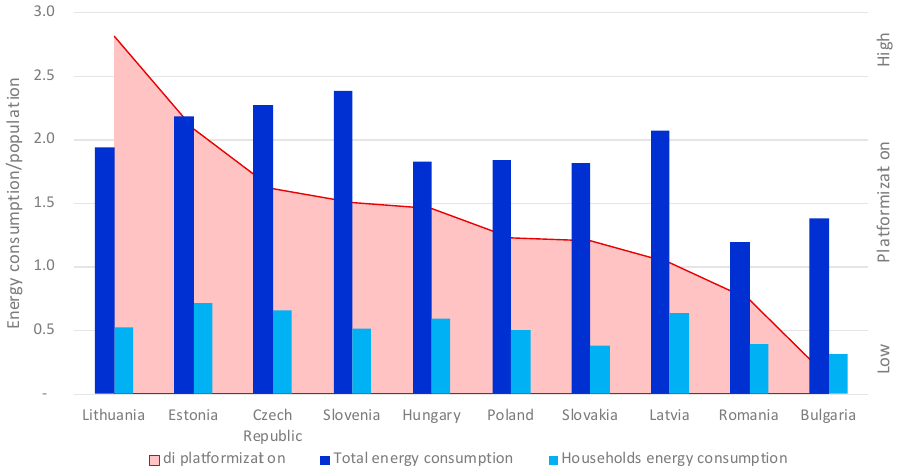
Figure 6. Platformization of CEE countries and the level of energy consumption in total and in households in 2018 per capita (in thousand tons of oil equivalent).